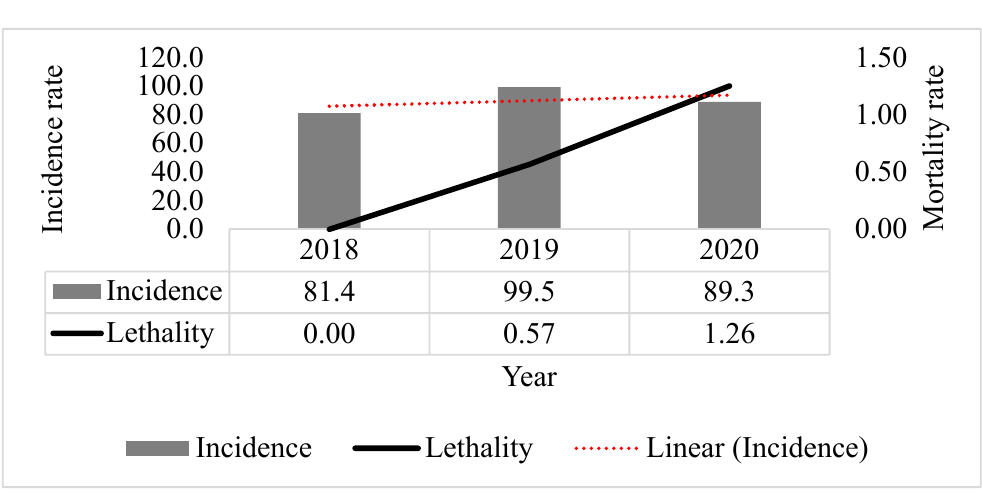
Figure 3. Tuberculosis incidence (per 100,000 inhabitants) and mortality rates in Ananindeua, Pará from 2018 to 2020. Data source: SINAN.